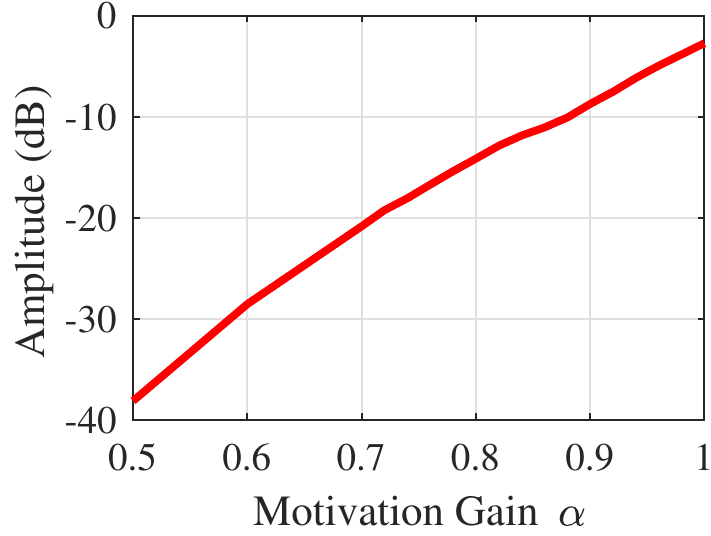
Figure 27. Amplitude of AMFC α = 0.5 to 1.